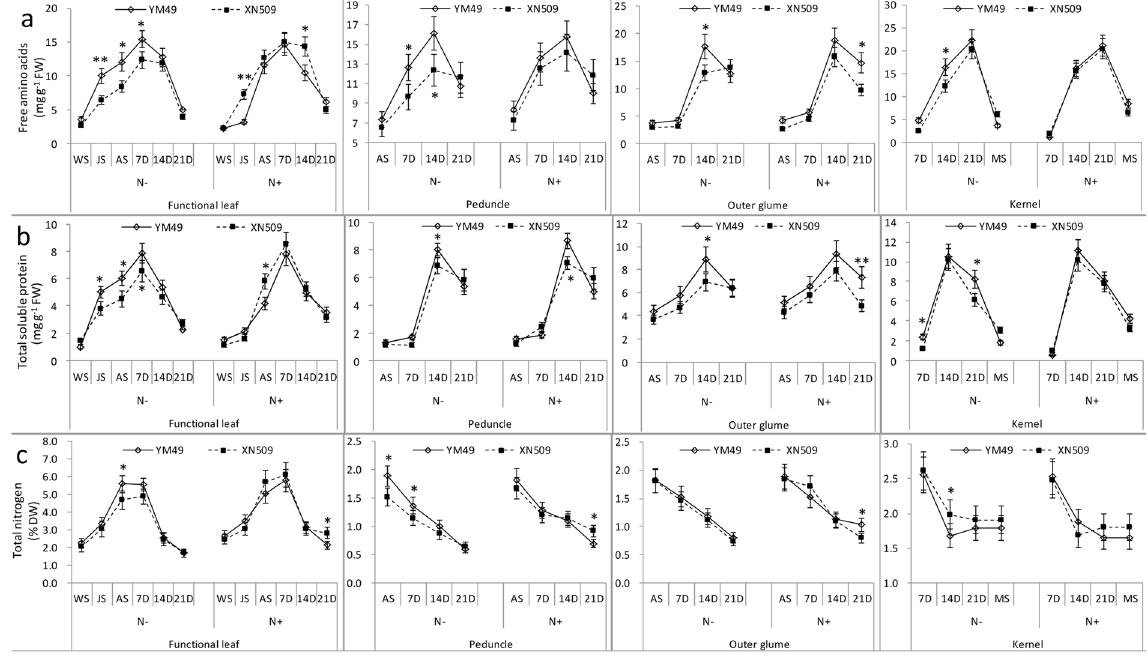
Figure 2. Changes in the indicators of N metabolism in relation to the plant growth stage and N level in various organs. Vertical bars correspond to the mean of three individual samples taken from three different pots ± SE. Asterisks ( * p < 0.05, LSD) indicate significant difference between the two genotypes. Double asterisks ( ** p < 0.01, LSD) indicate extreme significant difference between the two